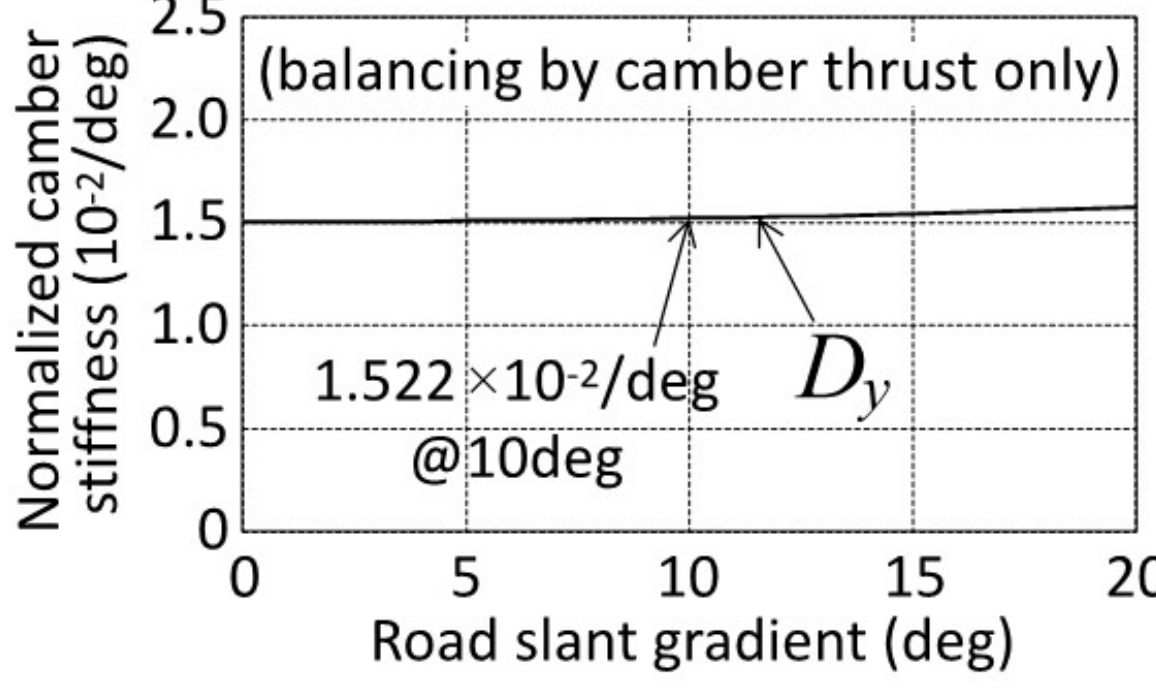
Figure 17. Normalized camber stiffness to cancel the road slant.